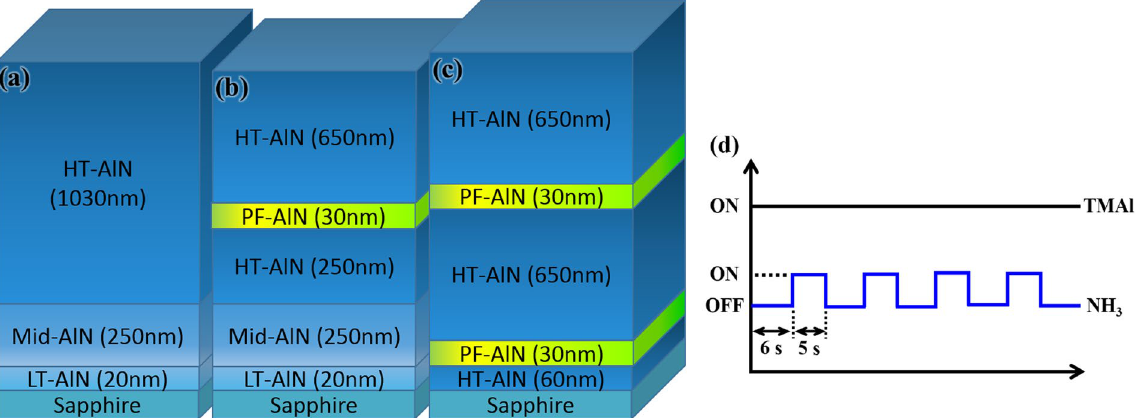
Figure 1. Layer structures of the ( a ) conventional CF sample; ( b ) SPF sample; ( c ) DPF sample. ( d ) Schematic illustration of the valve operation during the PF-AlN growth in ( b ) and ( c ). The on/off duration of NH3 flow is optimized to attain the atomically flat